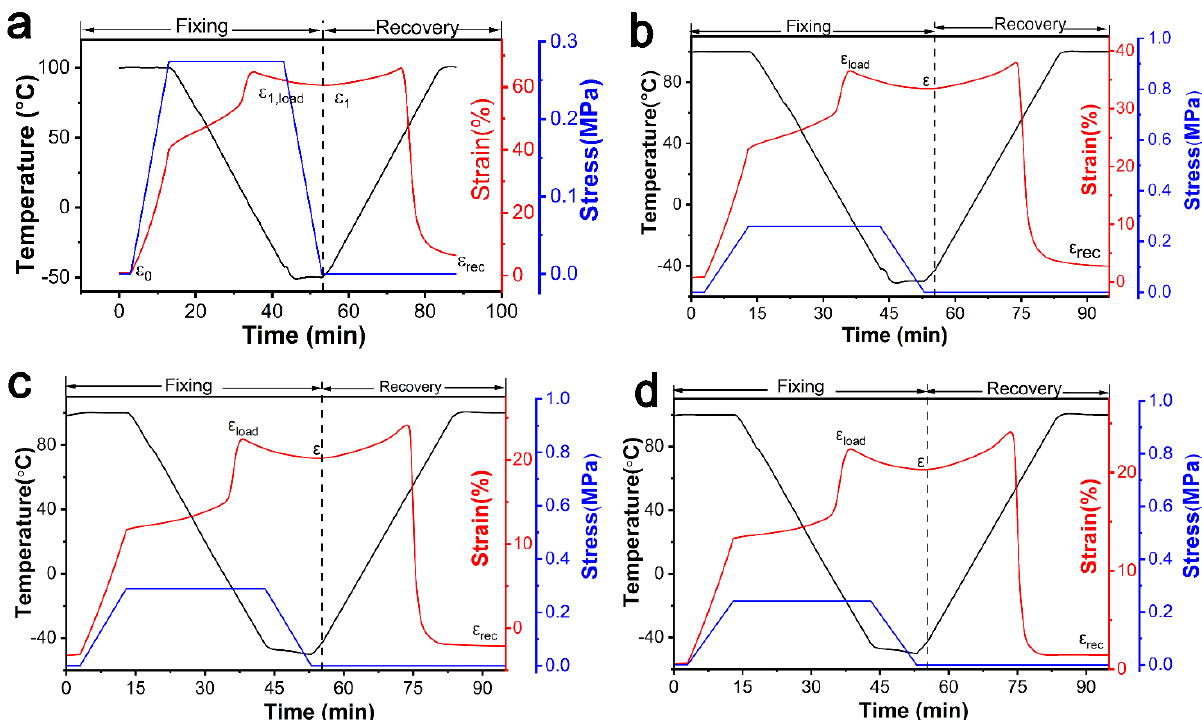
Figure 8. Shape memory performance of ER composites with different DCP content: ( a ) 0.2 phr; ( b ) 0.4 phr; ( c ) 0.8 phr; and ( d ) 1.2 phr. Table 2. Effect of the DCP dosage on the R f and R r values for SME in the composites.